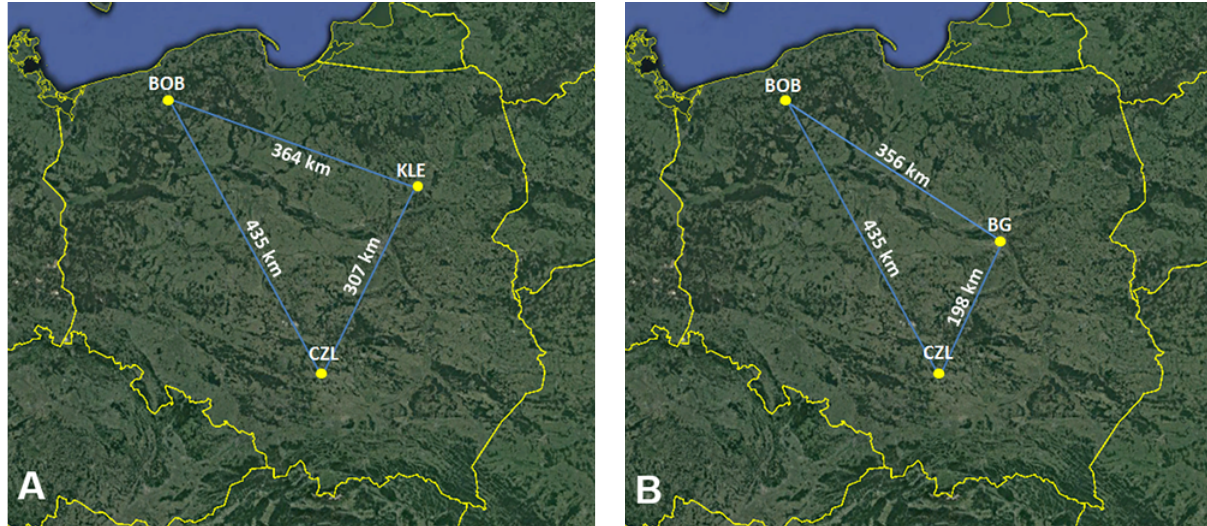
Fig. 1 Geographical distribution of P. caeruleum populations originally selected for the studies ( A ) and after replacing one natural population with the planted population in the University of Warsaw Botanical Garden ( B ).